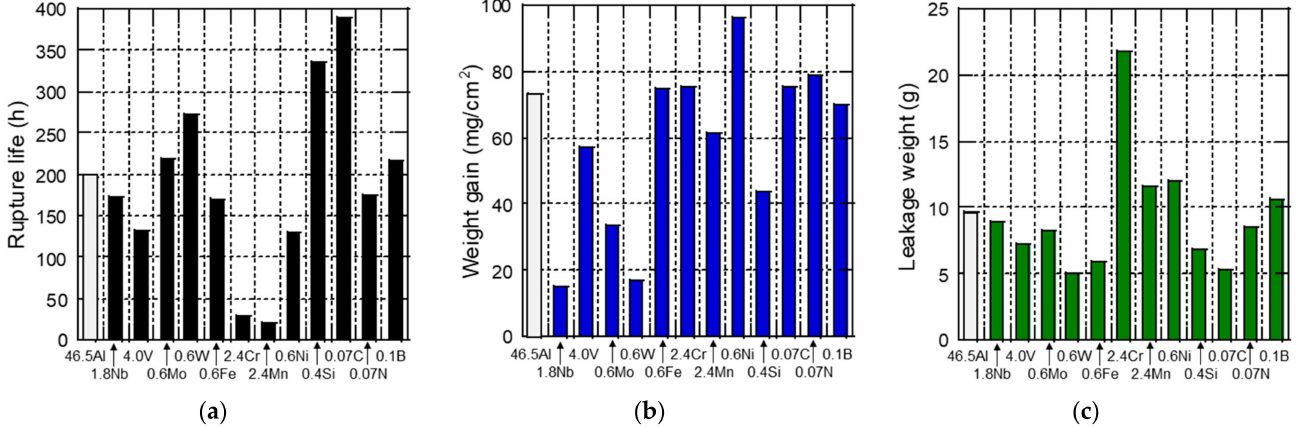
Figure 7. Effect of added elements in added amounts, considering the impact resistance, in the as-cast state: ( a ) rupture life in creep rupture test at 850 ◦ C/140 MPa; ( b ) weight gain in the atmospheric oxidation test at 1000 ◦ C/100 h; and ( c ) leakage weight of the molten metal during casting (average of three